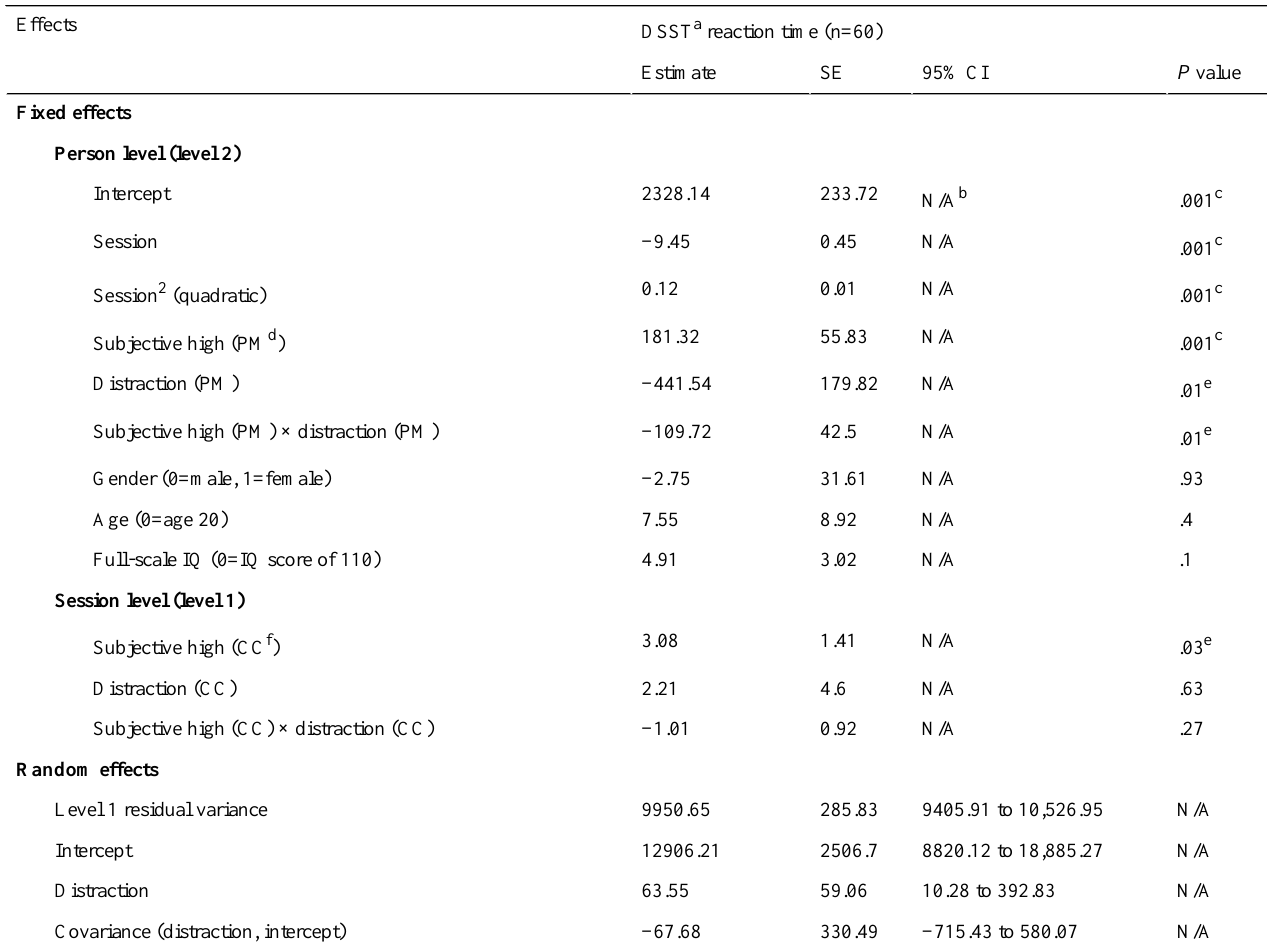
Table 5. Digit symbol substitution task: Multilevel model of marijuana high in relation to reaction